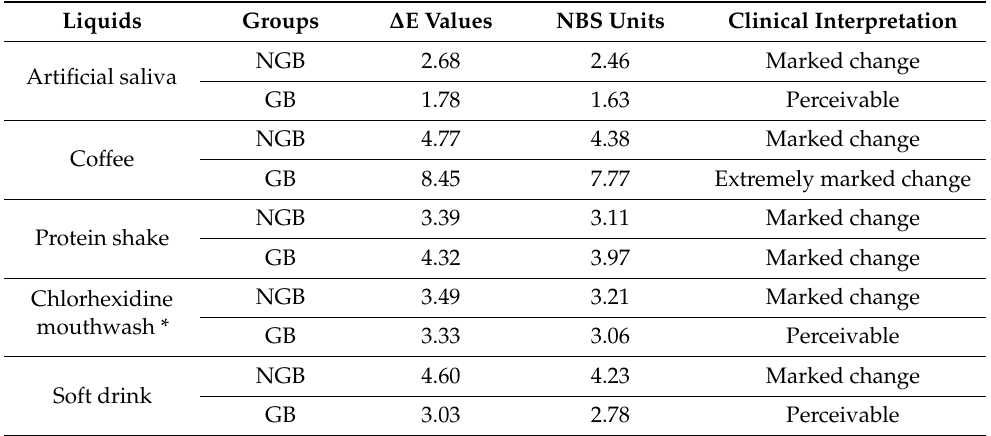
Table 5. Color change in multilayer zirconia group after 28 days.